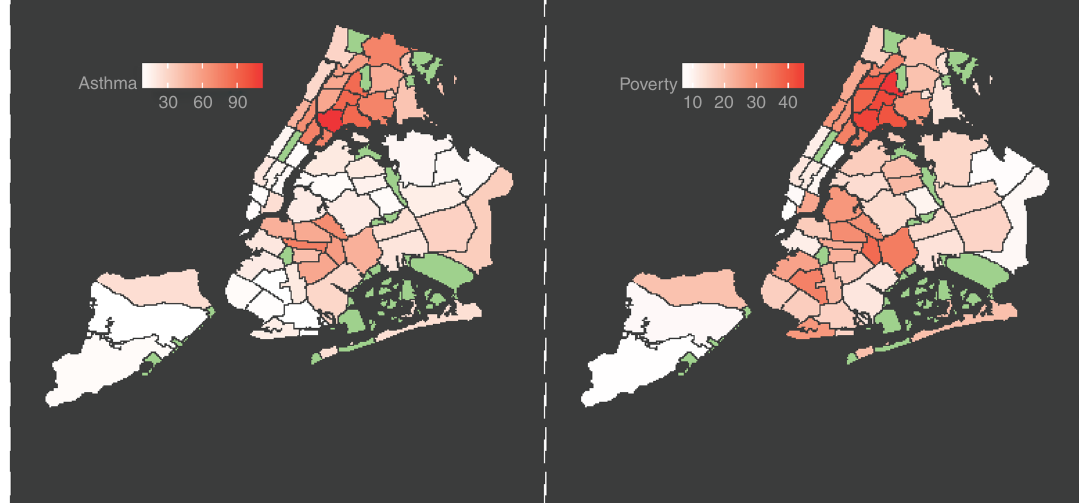
Fig. 1 NYC 2014 Community District Data for: (left) Children ’ s Asthma Admissions per 10,000 persons; and, (right) percent poverty in the same period. Green shaded areas represent parks, airports, etc. Figure rendered using data from NY State DOH